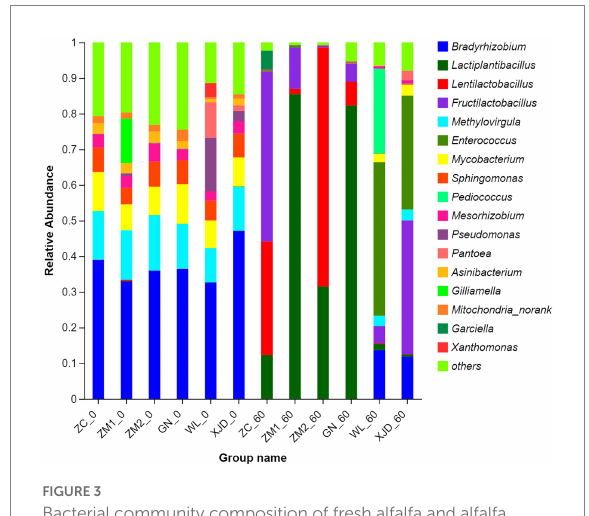
FIGURE 3 Bacterial community composition of fresh alfalfa and alfalfa silage at the genus level. ZC, Zhongcao No. 3; ZM1, Zhongmu No.1; ZM2, Zhongmu No. 2; GN, Gongnong No. 1; WL,WL168; XJD, xinjiangdaye; 0,0 day of ensiling; 60, 60 days of